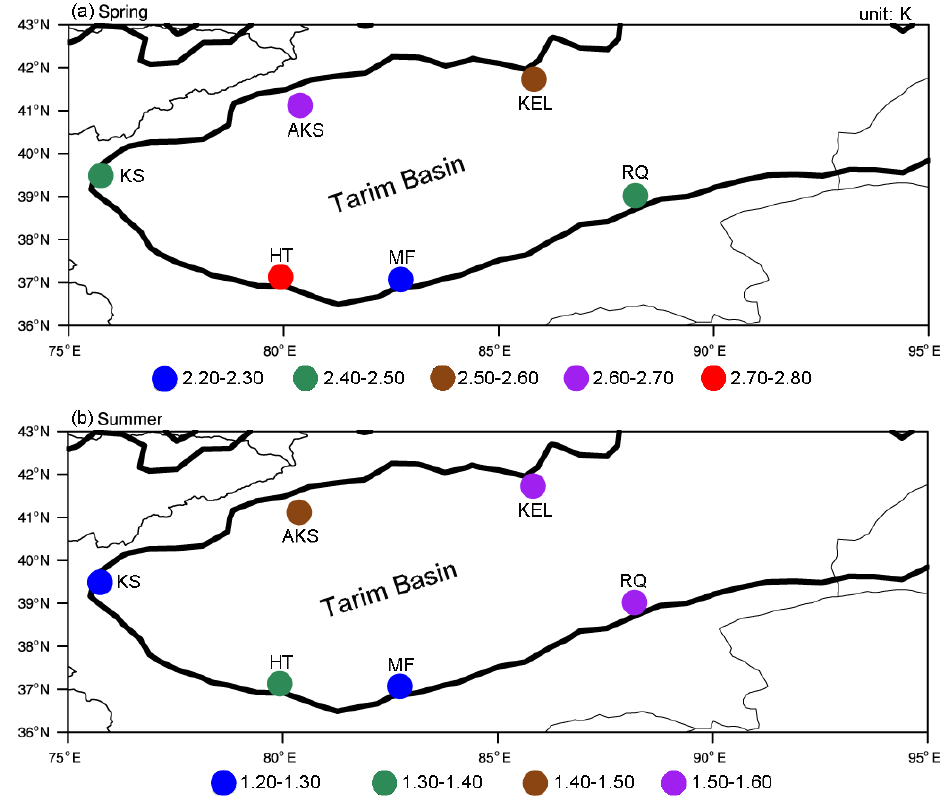
Figure 3. Average (cid:49)T between 500 and 300hPa in (a) spring and (b) summer. Dots indicate the site locations, while different colors indicate different heating